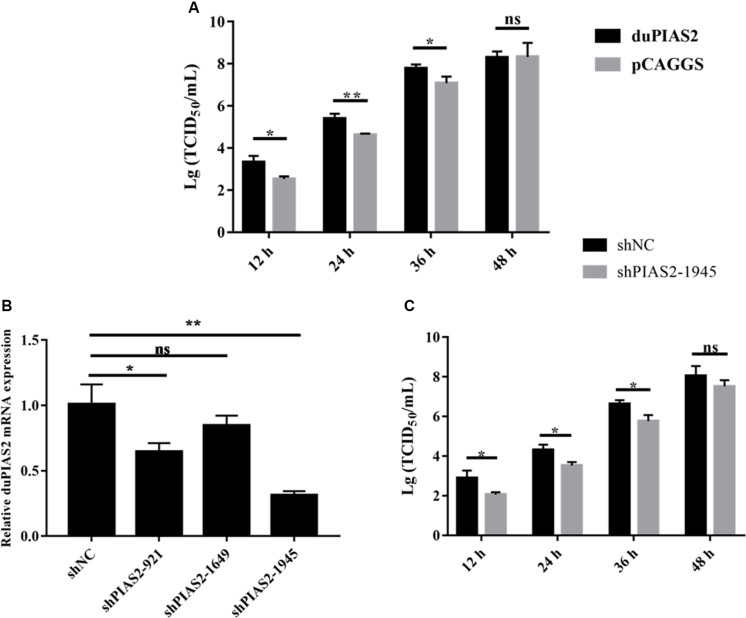
duPIAS2 promotes the replication of DK212. (A) DEF cells were transfected with empty vector or pCAGGS-duPIAS2-HA. At 24 h post-transfection, the cells were infected with 100 TCID50 of DK212. The culture supernatants were harvested for measurement of the viral TCID50 at 12, 24, 36, and 48 h post-infection, respectively. (B) DEF cells were transfected with three shRNA targeting duPIAS2 or negative control (shNC). After 36 h, the transfected cells were measured using qRT-PCR for the expression of endogenous duPIAS2. (C) DEF cells were transfected with shPIAS2-1945 or shNC. After 24 h, 100 TCID50/well DK212 was used to infect shRNA-treated DEF cells. Supernatants were collected at 12, 24, 36, and 48 hpi, and viral titers were measured by TCID50 assay. The experiment was repeated three times. The error bars represent the means and SDs (n = 3) and are compared using a student’s t-test. nsP > 0.05, *P < 0.05; **P < 0.01.